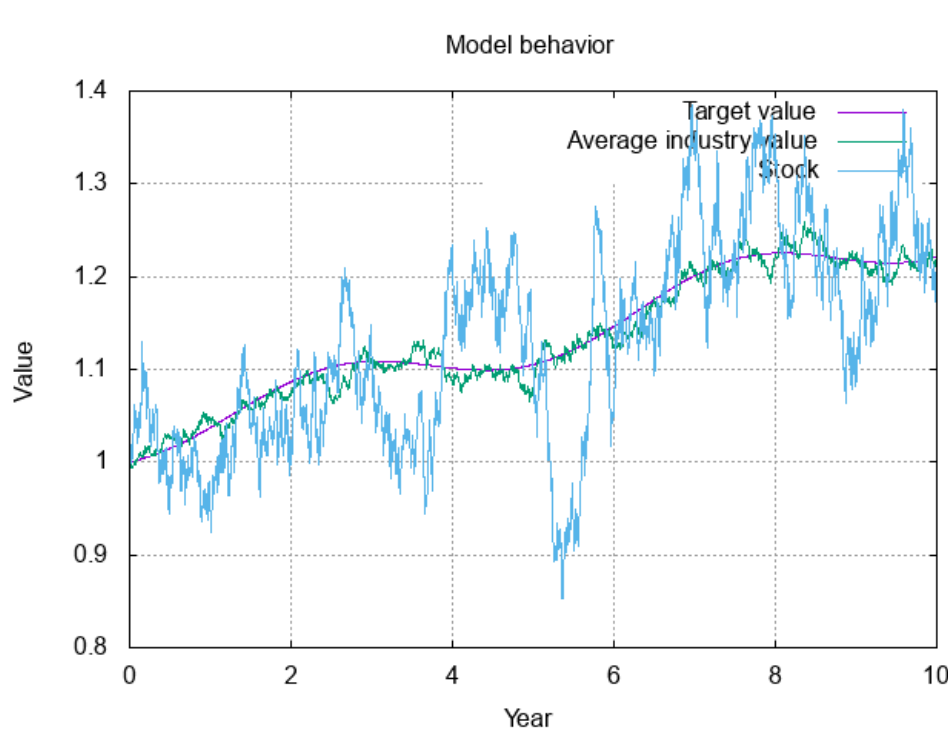
Figure 1. Market and one sample stock, mean reversion 5. The average firm value deviates around the underlying deterministic value, as do individual firms, but with higher volatility.